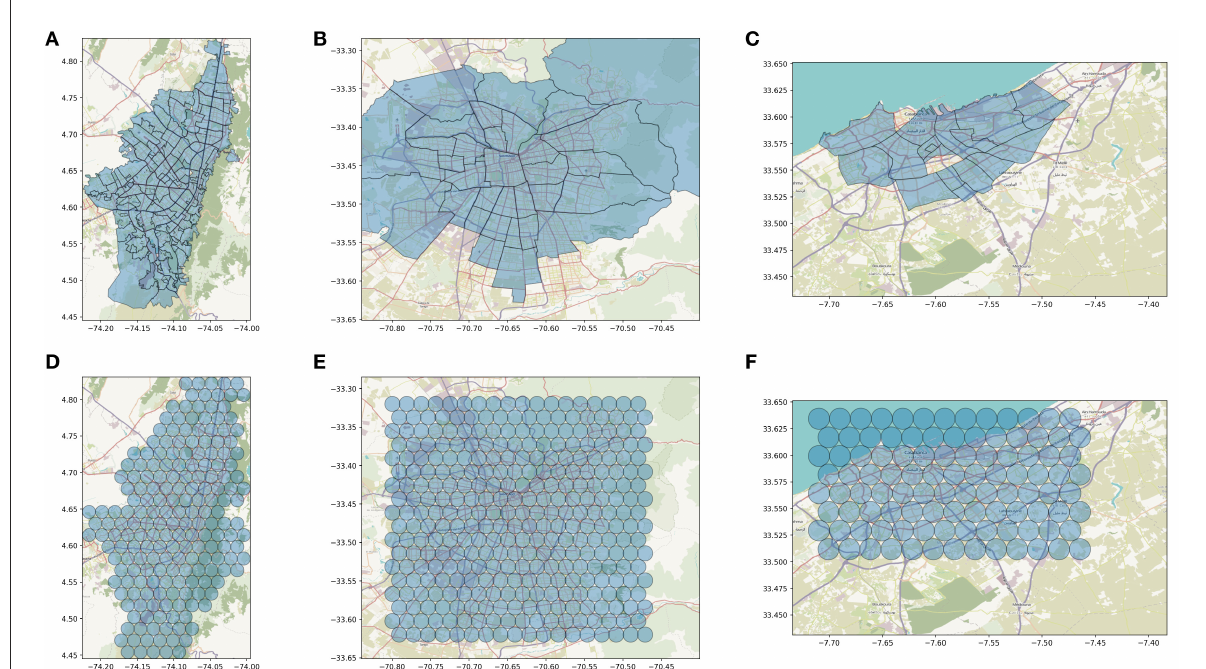
FIGURE2 Spatial targeting schemes for the queries of Bogota (A,D) , Santiago (B,E) , Casablanca (C,F) . For each city we show the administrative subdivisions for which socioeconomic data is available (upper panels) and the grid of circles of 1 km radius that we used to collect audience estimates. Only estimates for circles intersecting the administrative units were considered in the models. These are: 196 circles in Bogotá, 324 in Santiago, 104 in Casablanca.